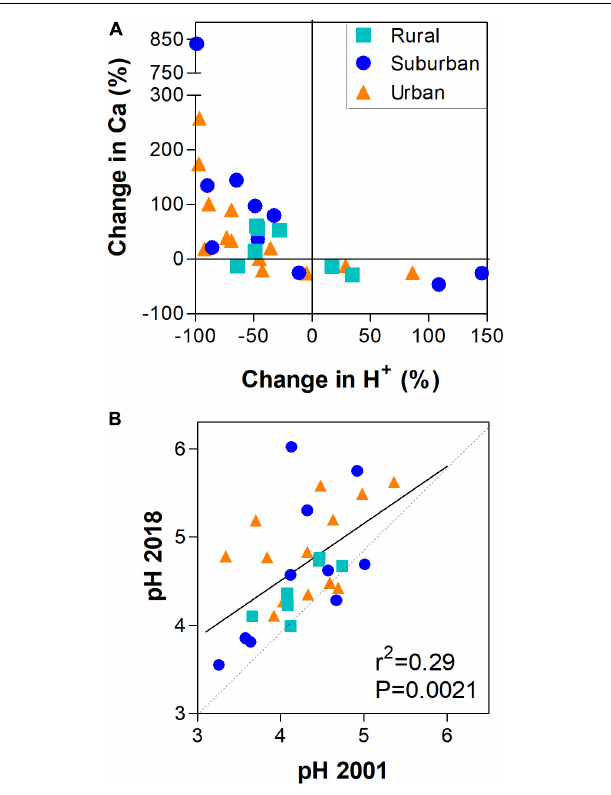
FIGURE 6 | Change in surface soil calcium levels and pH in urban, suburban and rural forest patches. (A) Change in Ca and change in H+ concentrations from 2001 to 2018. Points represent plot level data ( n = 36). (B) Correlation between soil pH in 2001 and 2018 at the plot level ( n = 36). The dotted line is the 1:1 line and the solid line is the regression line.